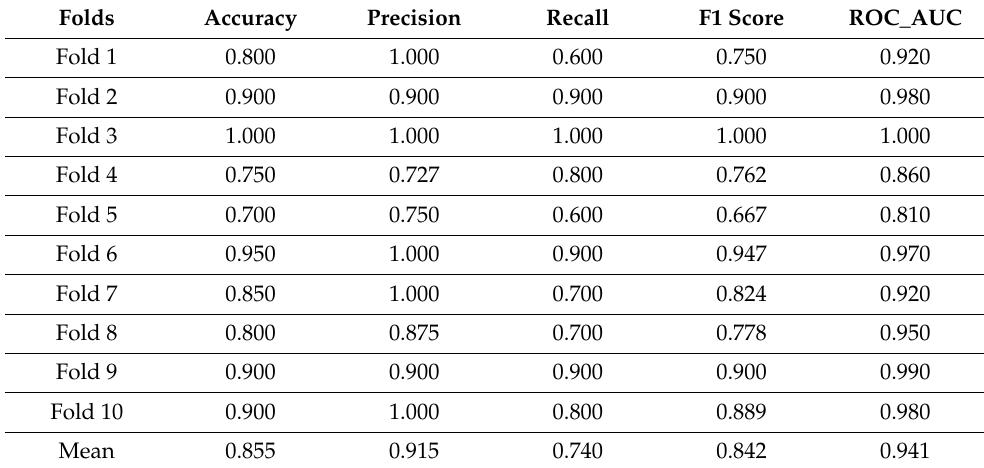
Table 1. Results from the 10-fold validation of GPC model with 7 PCs.